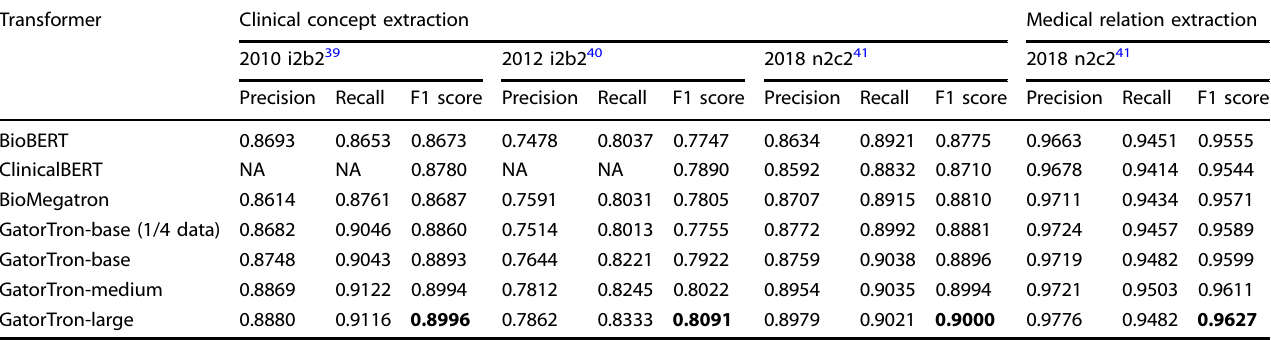
Table 1. Comparison of GatorTron with existing biomedical and clinical transformer models for clinical concept extraction and medical relation extraction. Transformer